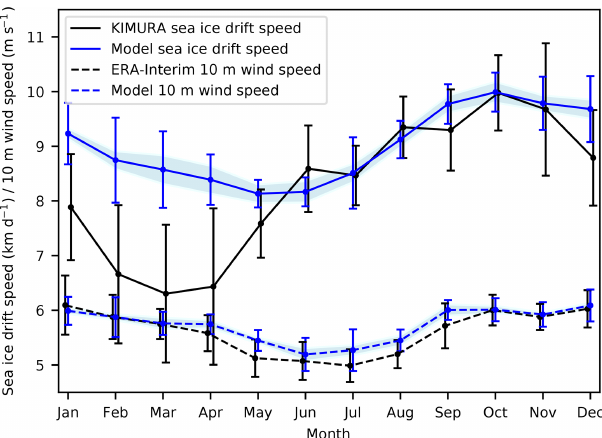
Figure 2. Mean annual cycle of sea ice drift speed (kmd − 1 , solid lines) and 10m wind speed (ms − 1 , dashed lines), based on the model (ensemble mean of HIRHAM–NAOSIM 2.0; blue lines) and observation/reanalysis (KIMURA ice drift, ERA-I wind; black lines) for 2003–2014 over the study domain (indicated in Fig. 1). The across-ensemble scatter (standard deviation) of the simulations is included as shaded area. The interannual variation is shown by error